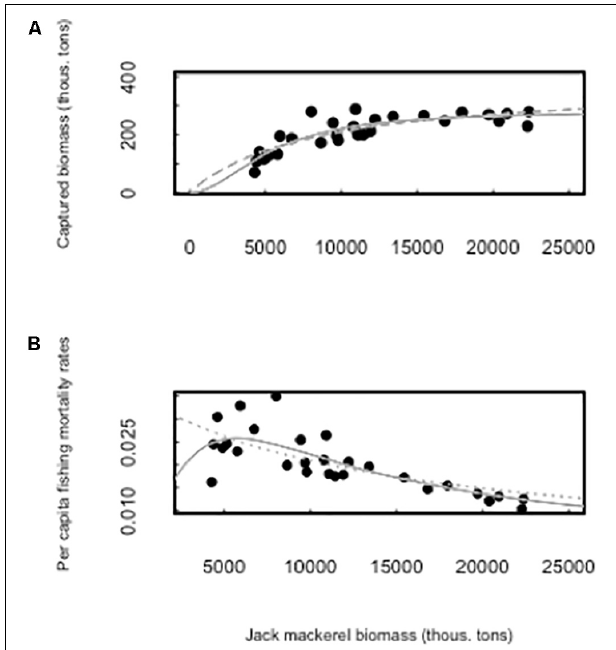
FIGURE 2 | (A) The behavioral responses of the fishery catch per effort unit to changes in jack-mackerel stock biomass, the gray dotted line is the type II behavioral response model while the gray solid line is the type III functional response model. (B) Resulting per capita fishing death rates from the type II (dotted line) and III (solid line) behavioral responses of the